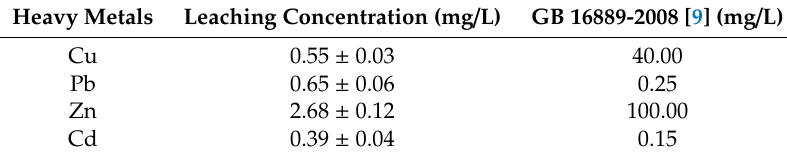
Table 2. Leaching concentration of heavy metals in mine tailings.